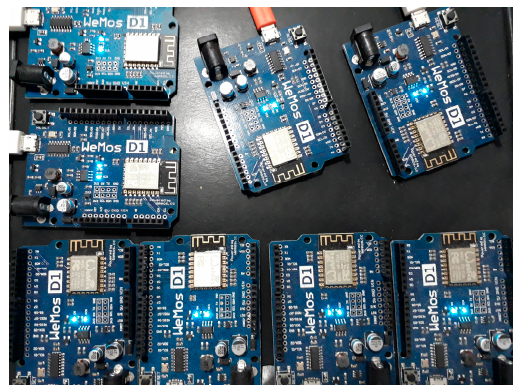
Figure 7. The WeMos modules used in the experiments.